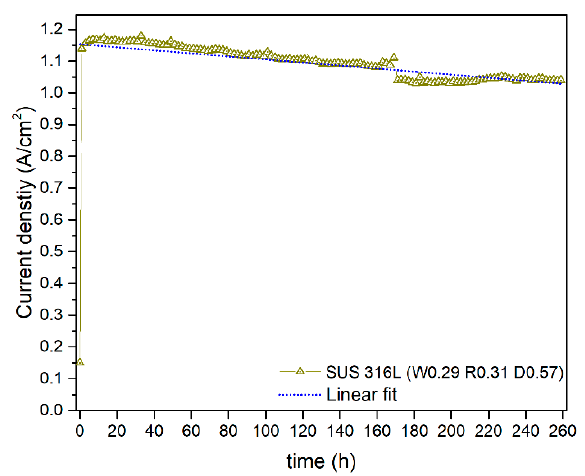
Figure 13. Current density at 0.6 V for 260 h operation of the single cells with PBF-built SUS 316L BP (W0.29, R0.31, and D0.57).